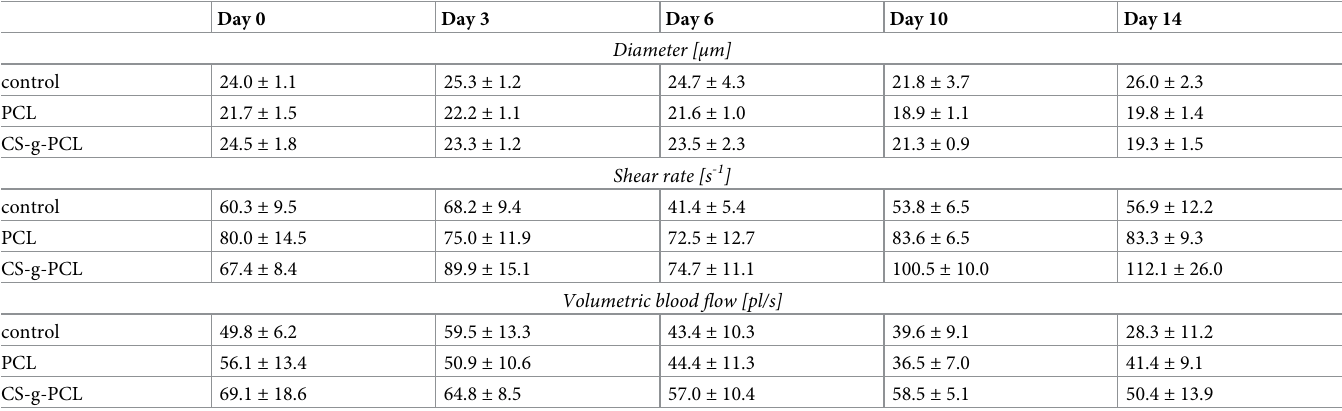
Table 2. Venular diameters in μ m, volumetric blood flow in pl/s and wall shear rate in s -1 of postcapillary and collecting venules at the border zones of the control group scaffold (control), the unmodified PCL fiber mat group (PCL) and PCL fiber mat modified with CS-g-PCL group immediately (d0) and 3, 6, 10 and 14 days after implantation. Values are expressed as means ± SEM.